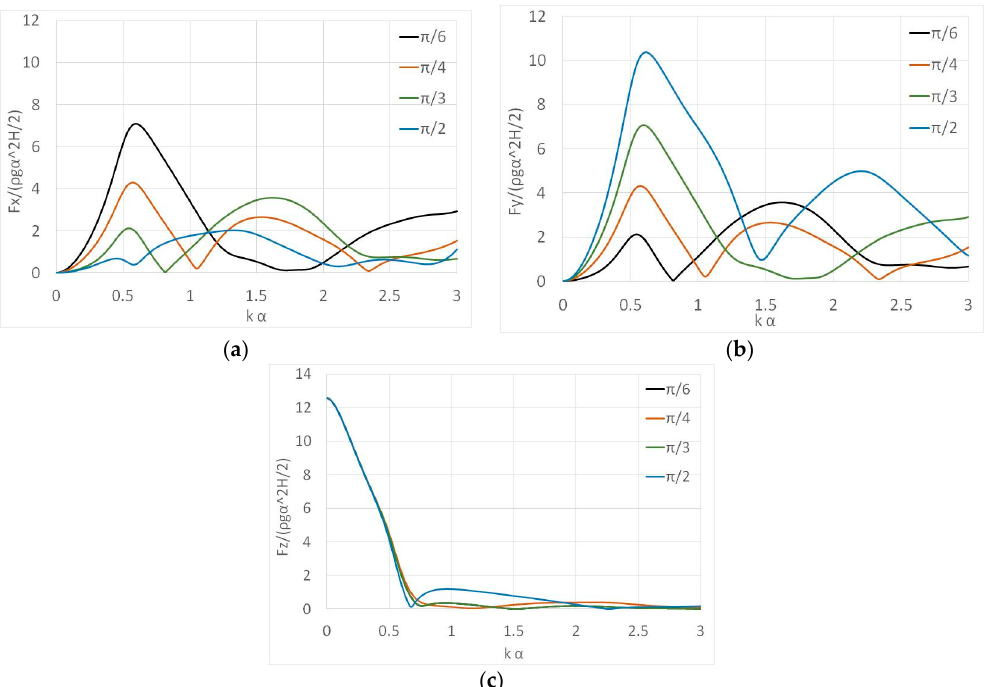
Figure 6. Exciting forces on a floating cylindrical floater placed in front of an orthogonally (right angle) breakwater using the method of images for β = π /6; π /4; π /3; π /2: ( a ) horizontal-exciting force on x -axis; ( b ) horizontal-exciting force on y -axis; ( c ) vertical-exciting force on z -axis.